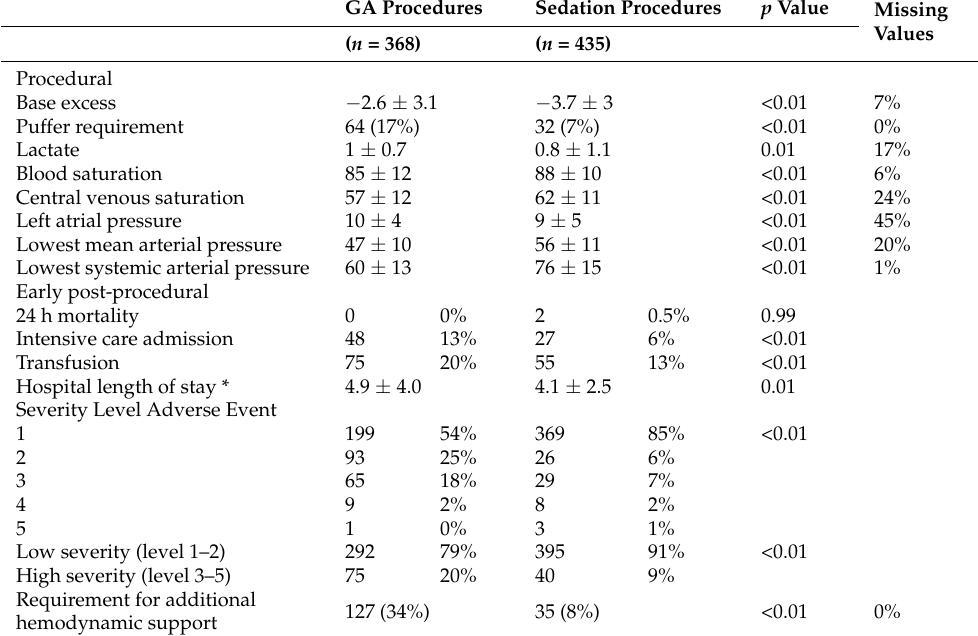
Table 3. Procedural and post-procedural early